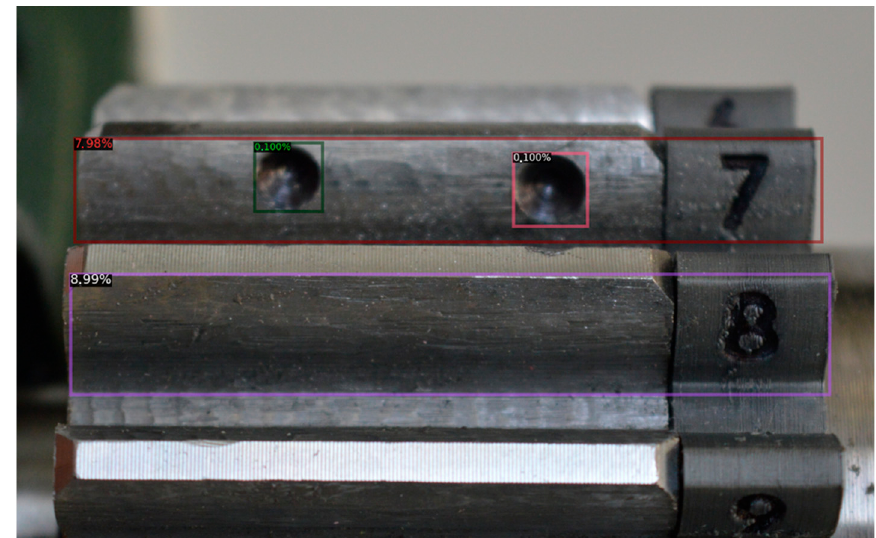
Figure 3. Output image of the gear with smaller pitting damage.